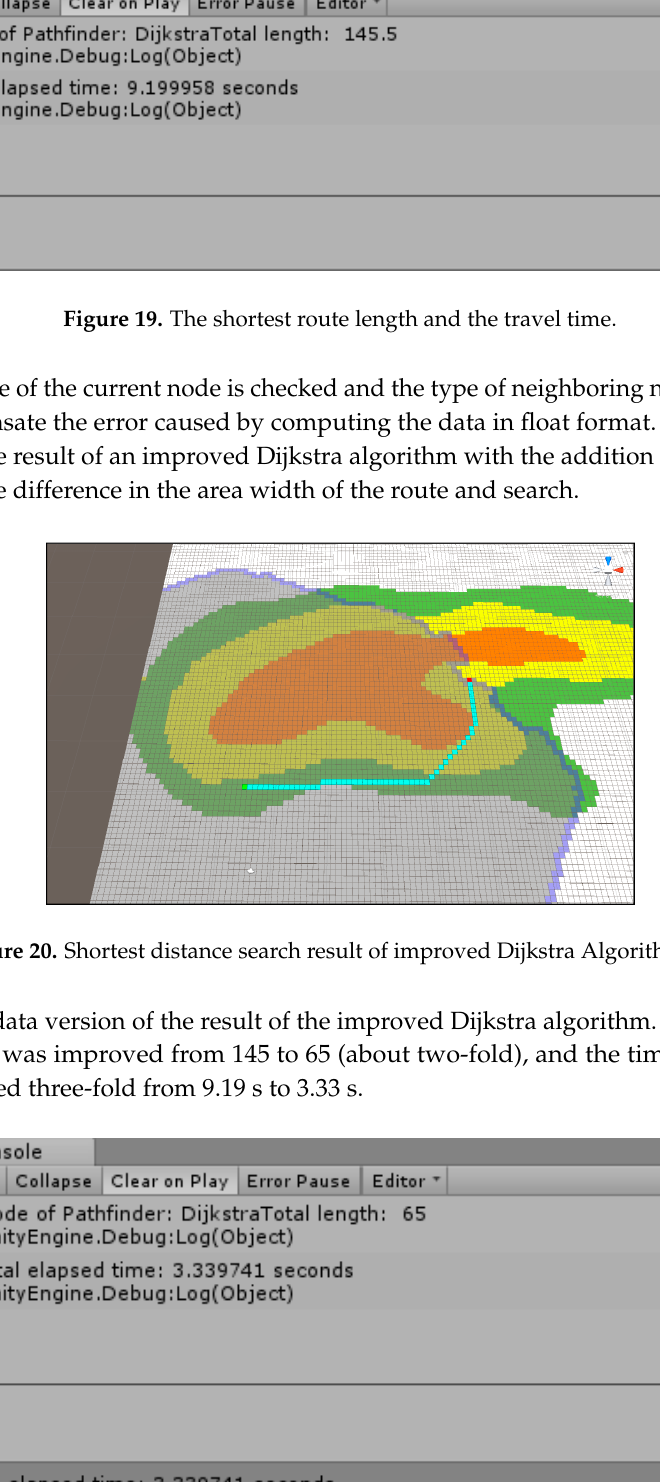
Figure 21. Shortest distance search result of improved Dijkstra Algorithm (2).